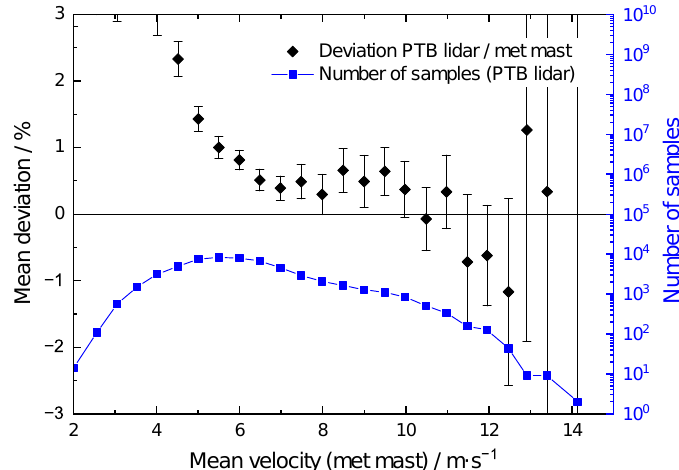
Figure 7. Results of the 2016 comparative measurement between the PTB bistatic lidar and a cup anemometer mounted on a met mast boom at a height of 100 m in disturbed flow at a measurement height of 100 m, evaluated according to IEC 61400-12-1 using 1 s intervals. The PTB bistatic lidar exhibits absolute deviations below 1% over a large range of wind speeds from 6 m · s − 1 to 12 m · s − 1 . The PTB bistatic lidar’s deviation only increases significantly beyond 1% at very low or very high wind speeds. Extensive investigations and mathematical simulations showed that this is due to the different dynamic responses of the sensing devices employed, and also due to the limited correlation of wind velocities sampled at slightly different locations.